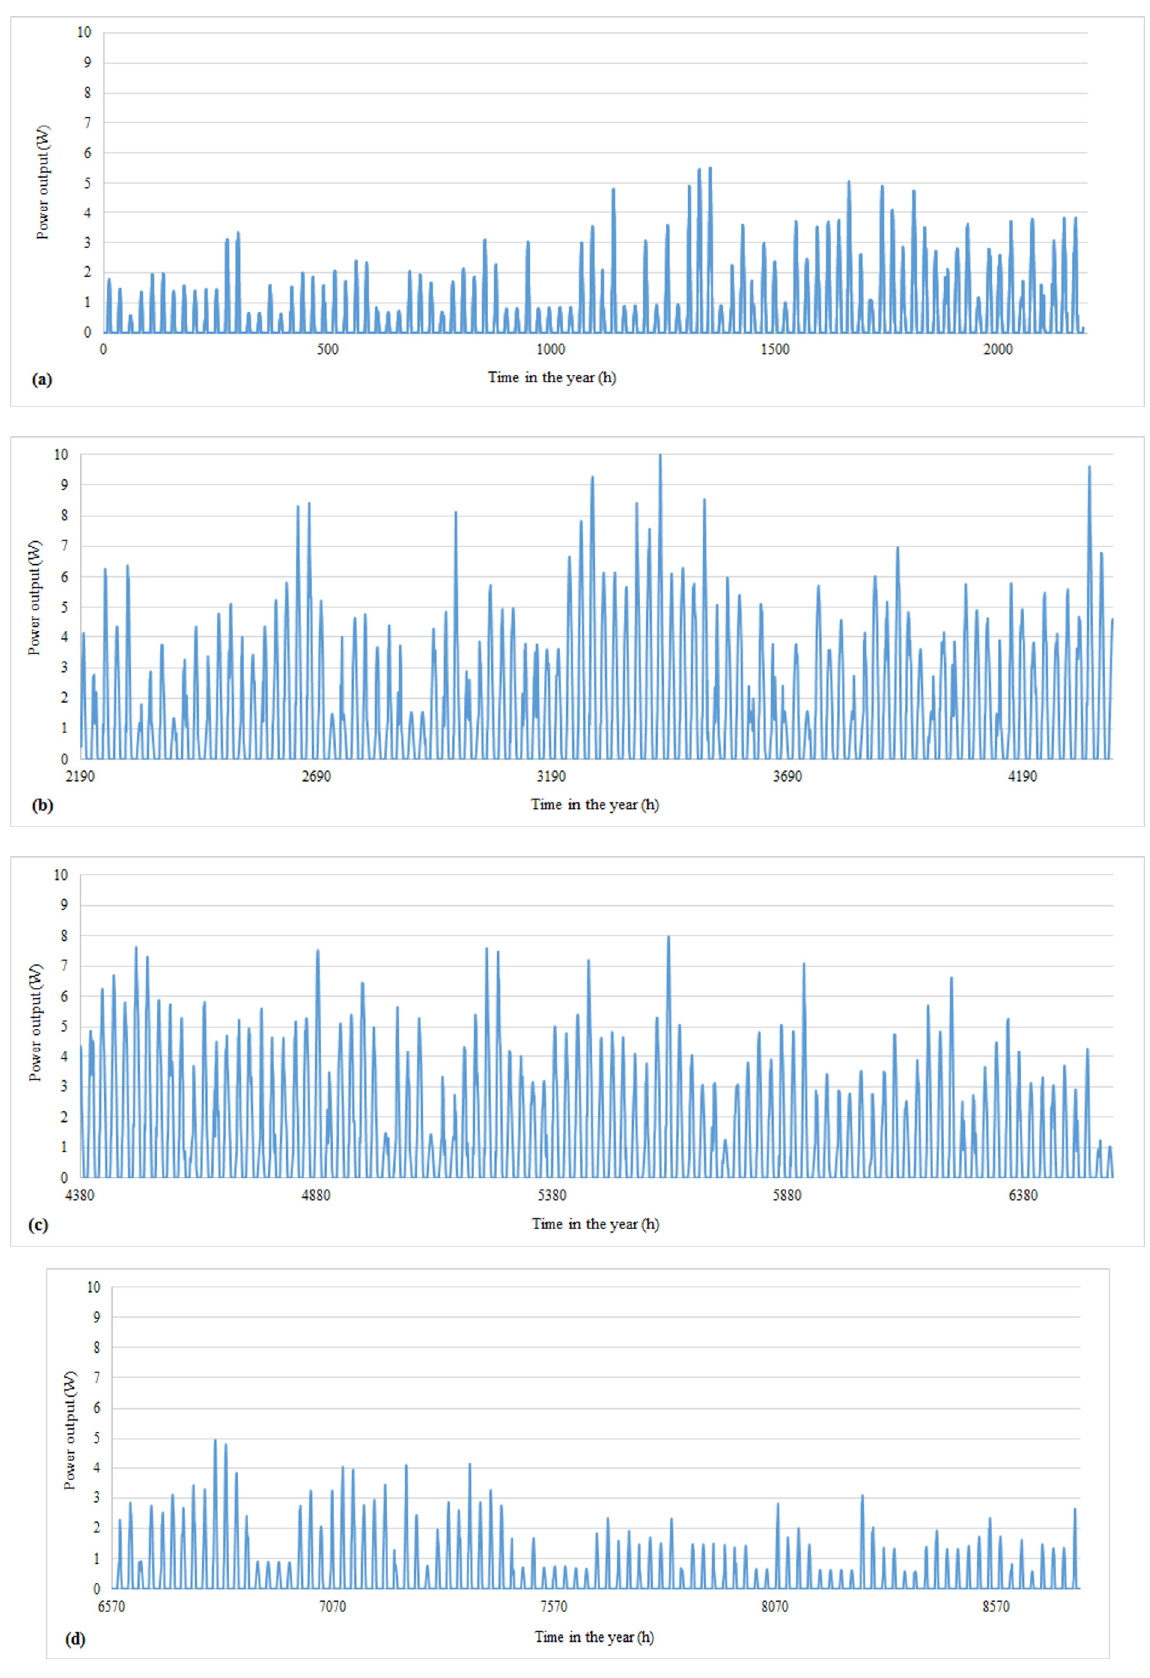
Figure 6. ( a – d ). Electric power generated by the solar chimney system for each quarter of the year.